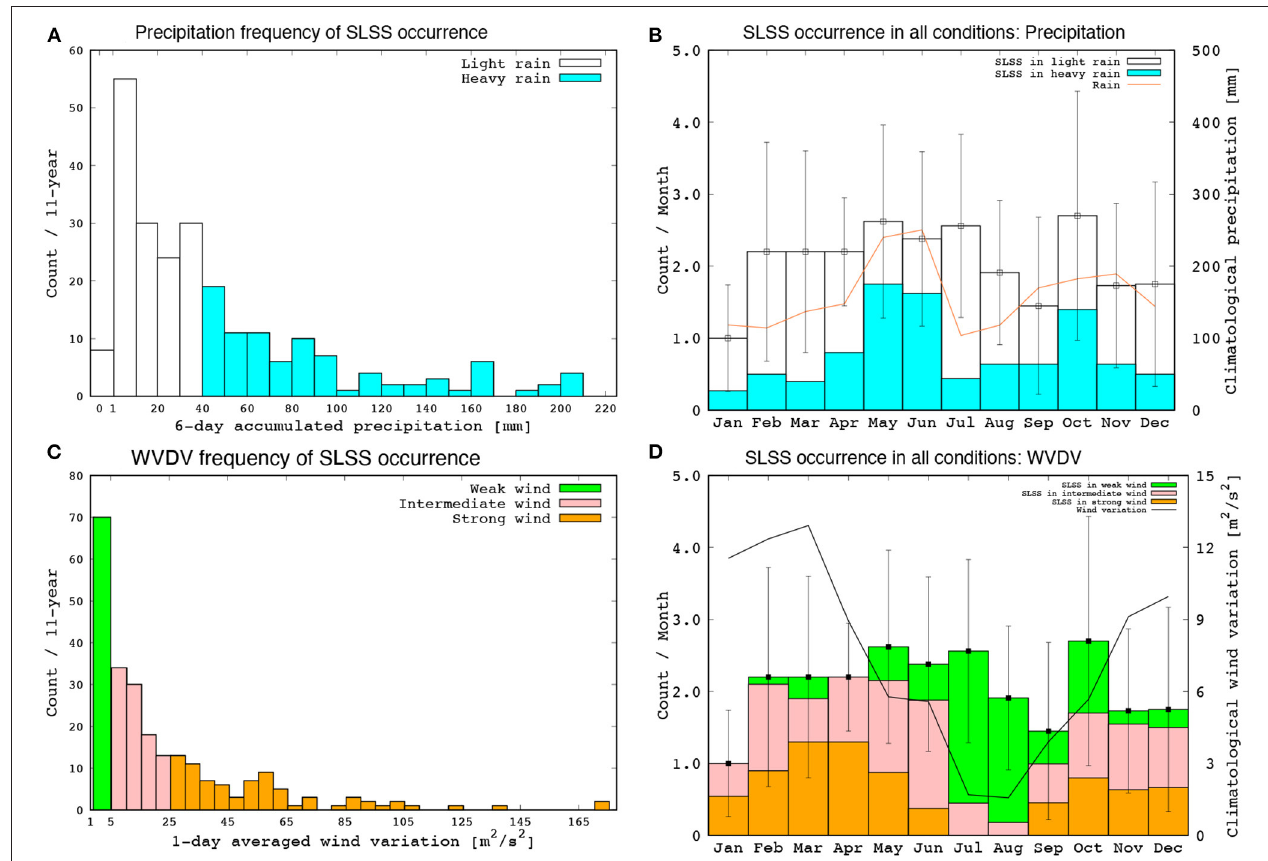
FIGURE 3 | The occurrence frequencies of 244 SLSS events in the 11-year analysis period sorted by (A) total count arranged into bins of 6-day accumulated precipitation (from − 3 days to + 3 days relative to the start time of each SLSS event and with a unit of mm) based on GSMaP hourly data at the location of the KEO buoy. (B) Monthly averaged count where white and blue bars indicate SLSS events in light- and heavy-rain conditions, respectively, with a light-to-heavy transition set to 40 mm/6-day. (C) Same as (A) and (B) except for being sorted by total count in bins of wind velocity subdiurnal variation (WVDV) with a unit of m 2 / s 2 and (D) monthly averaged count where green, pink and orange bars indicate SLSS events in weak-, intermediate-, and strong-wind conditions, respectively, with transitions at 5 and 25 m 2 / s 2 . WVDV for each SLSS event has been calculated as equation (4) with an average from − 0.5 days to + 0.5 days relative to the start time of each SLSS event and using JRA55-do 10m wind velocity 3 hourly data at the location of the KEO buoy. The monthly climatology profiles of GSMaP precipitation (with a unit of mm and indicated by tics on the right vertical axis) and of JRA55-do WVDV (with a unit of m 2 / s 2 and indicated by tics on the right vertical axis) at the location of the KEO buoy are calculated independently from SLSS events throughout the 11-year analysis period and are plotted in (B) as an orange line and in (D) as a black line. Monthly error bars in (B) and (D) are for all rain/wind conditions encountered over these 11